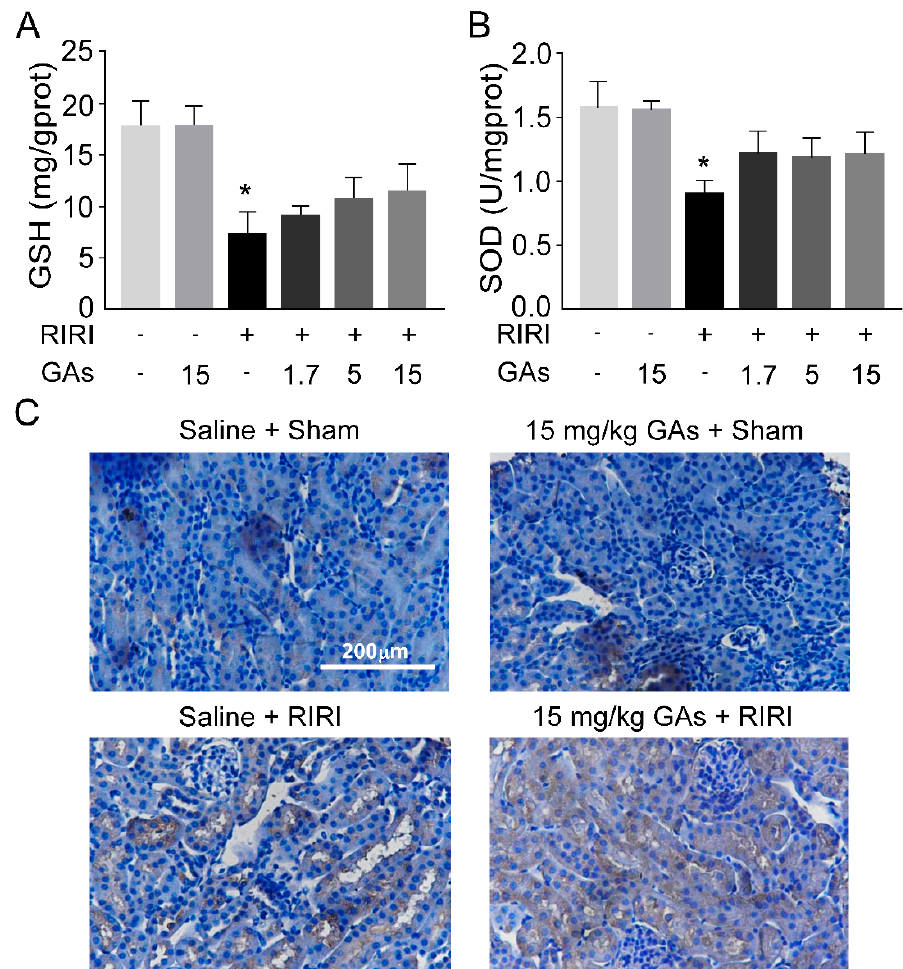
Figure 2. GAs attenuated RIRI-induced renal injury not primarily through suppressing oxidative stress. ( A ) GSH. ( B ) SOD. ( C ) Immunohistochemical localization of 8-OHdG. Values are expressed as the mean ± SEM ( n = 6). * p < 0.05 compared with Saline + Sham group (two-tailed Student’s t -test or one-way ANOVA).